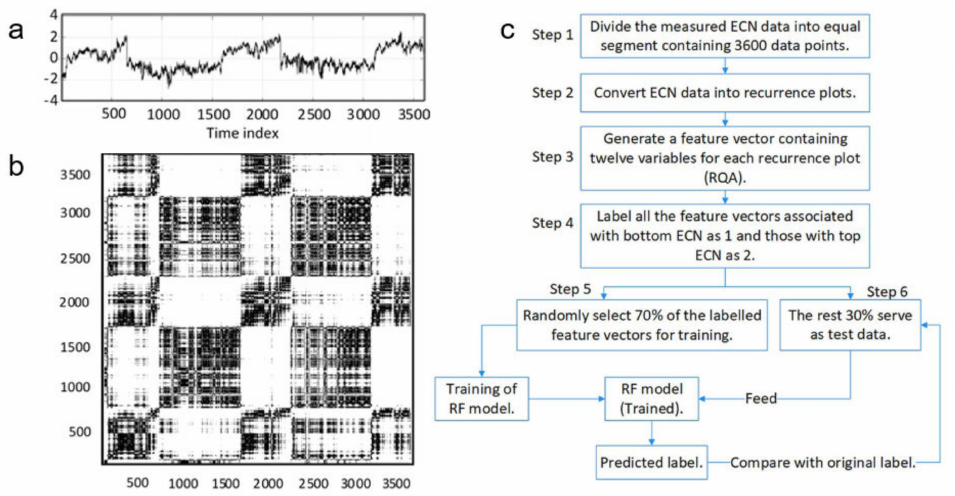
Figure 10. The procedure of employing electrochemical noise data as input to build a random forest model for the identification of CUI types. ( a ) Electrochemical noise data collected from an experimental CUI rig. ( b ) Recurrence plot produced from electrochemical noise data input. ( c ) Steps for training a random forest model to identify the form of CUI. Reprinted with permission from Ref. [94]. Copyright 2020 Springer